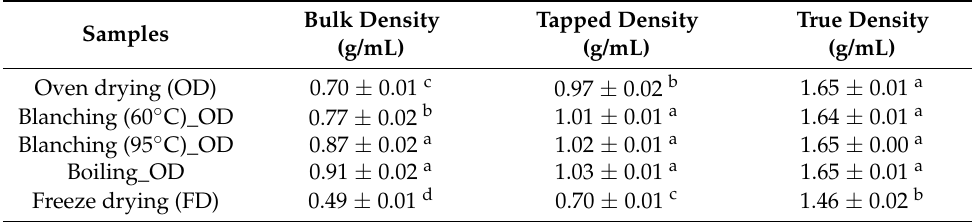
Table 3. Bulk density, tapped density, and true density of potato flour prepared under different pretreatment and drying